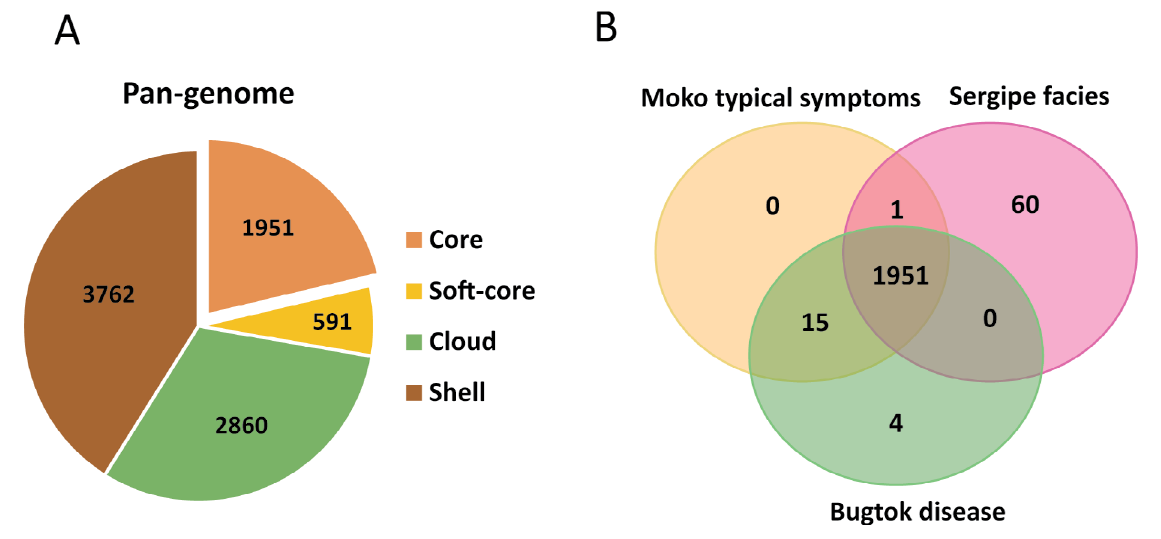
Figure 1 – Pan-genome representation of the Ralstonia solanacearum Moko ecotype generated by Roary software. (A) Gene categories (core, softcore, shell, and cloud) present in genomes were identified with 90% percent identity. (B) Venn diagram showing clusters present in the genome of R. solanacearum Moko ecotype strains and its symptomatological variants. Strains of Moko ecotype causing Bugtok symptoms (CIP417 and Molk2), Sergipe facies (IBSBF2570 and SFC), and typical symptoms of Moko (all other strains) are shown.